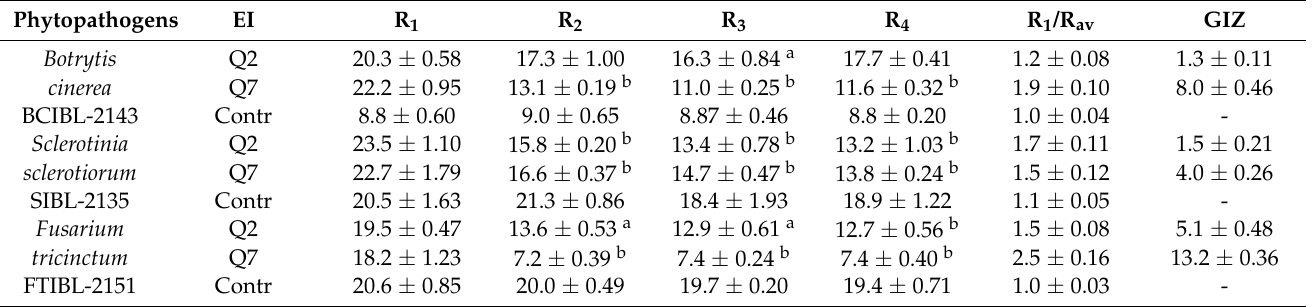
Table 2. Effect of endophytic isolate on linear growth parameters (mm) of micromycetes (x ± SE, n =